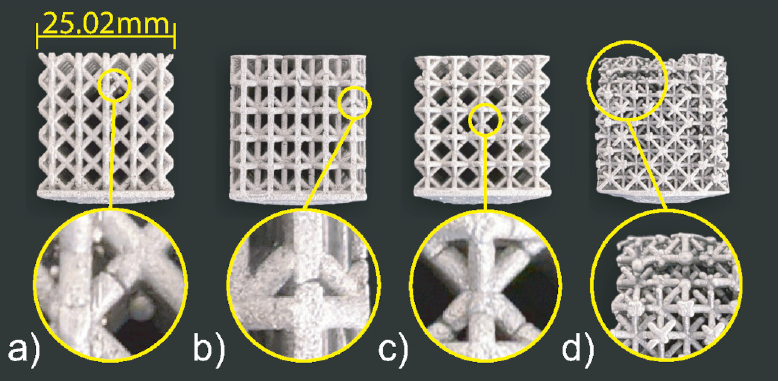
Figure 10. Set 2 cast structures: ( a ) Proposed cell, ( b ) Hourglass, ( c ) Rhombic, and ( d ) Octet-Truss. Table 4. Lattice topology comparison casting experiment